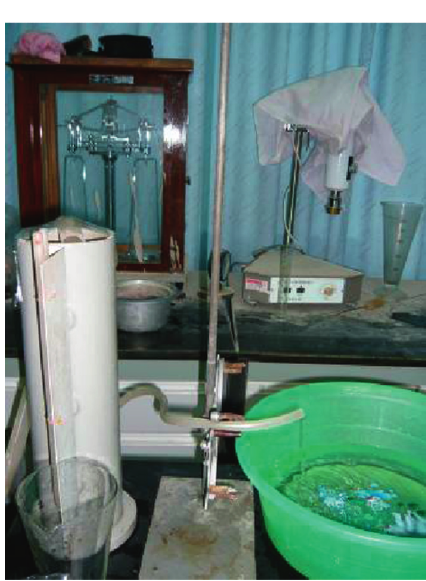
Figure 4: Physical photos of the coefficient of permeability ex- periments on the grouted gravel (sand) stone body.